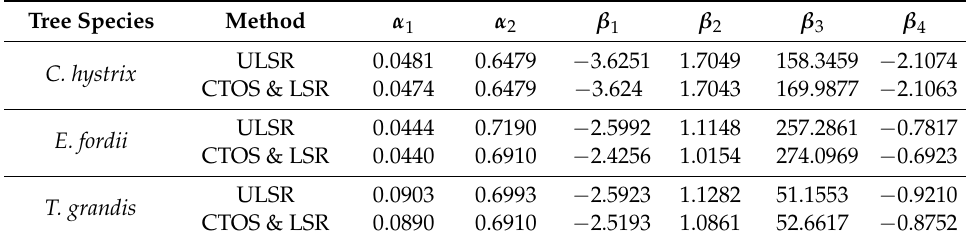
Table 3. Parameter estimates of Equation (1) obtained from both ULSR and CTOS & LSR based on the full data-set from three species ( C. hystrix , E. fordii, and T. grandi ), α 1 − α 2 , joint point parameters; − β β 1 4 , model parameters.